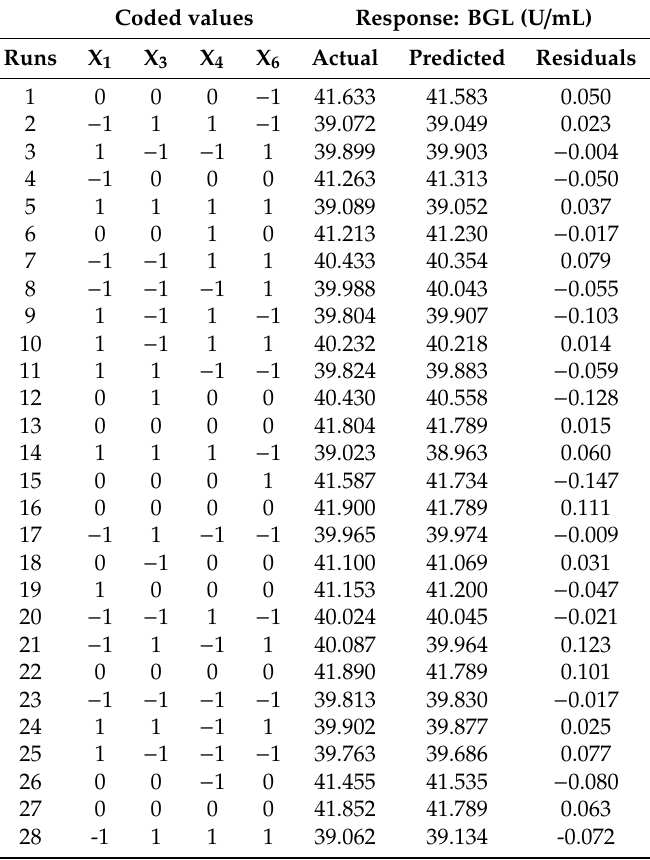
Table 6. CCD for production optimisation of S. griseus recombinant β -glucosidase. The table depicts coded values, along with the experimental response: BGL (U / mL), actual, predicted, and residuals (the di ff erence between the actual and predicted